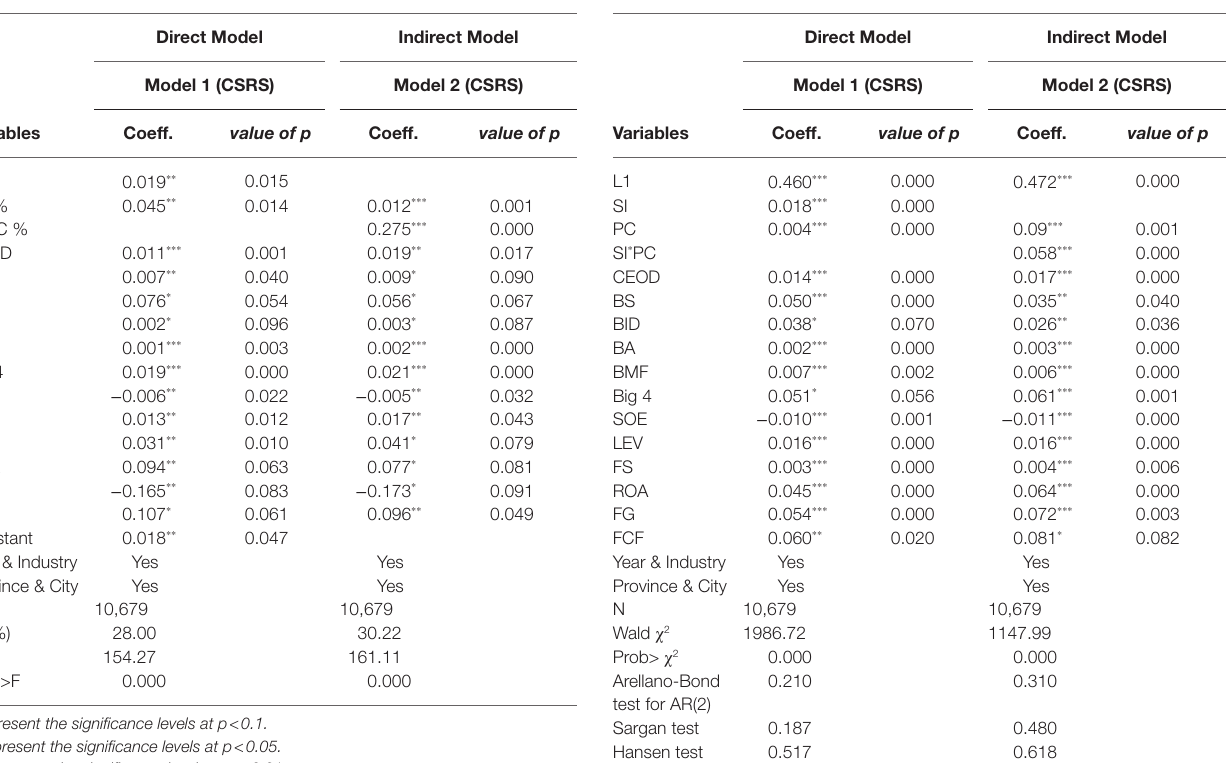
TABLE 7 | Alternative measure of PC. TABLE 8 | GMM